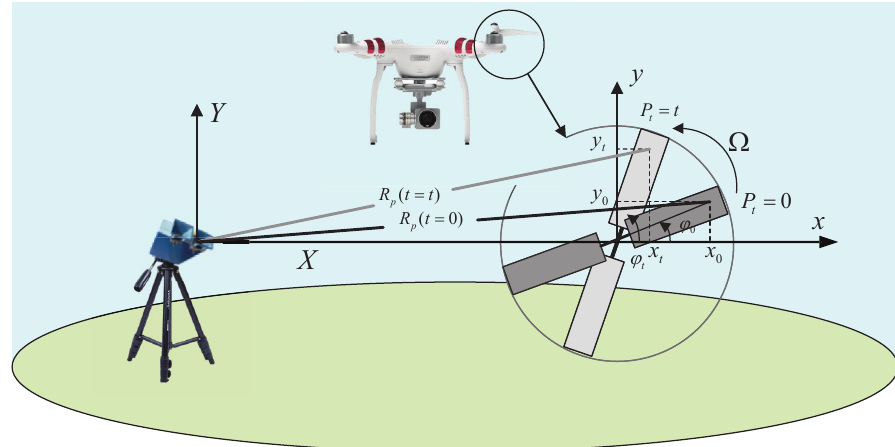
Figure 1. Micro-Doppler effect of UAV’s